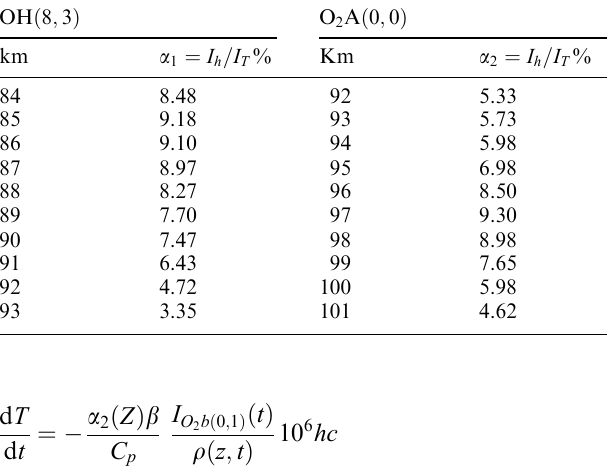
Table 3. Observed fraction of the column emission rate as a function of altitude for the OH (cid:133) 8 ; 3 (cid:134) and O 2 A (cid:133) 0 ; 0 (cid:134) (Melo, 1994) where (cid:97) (cid:136) I h = I T ( I h is the observed column emission rate at a fixed altitude and I T is the observed total column emission rate)